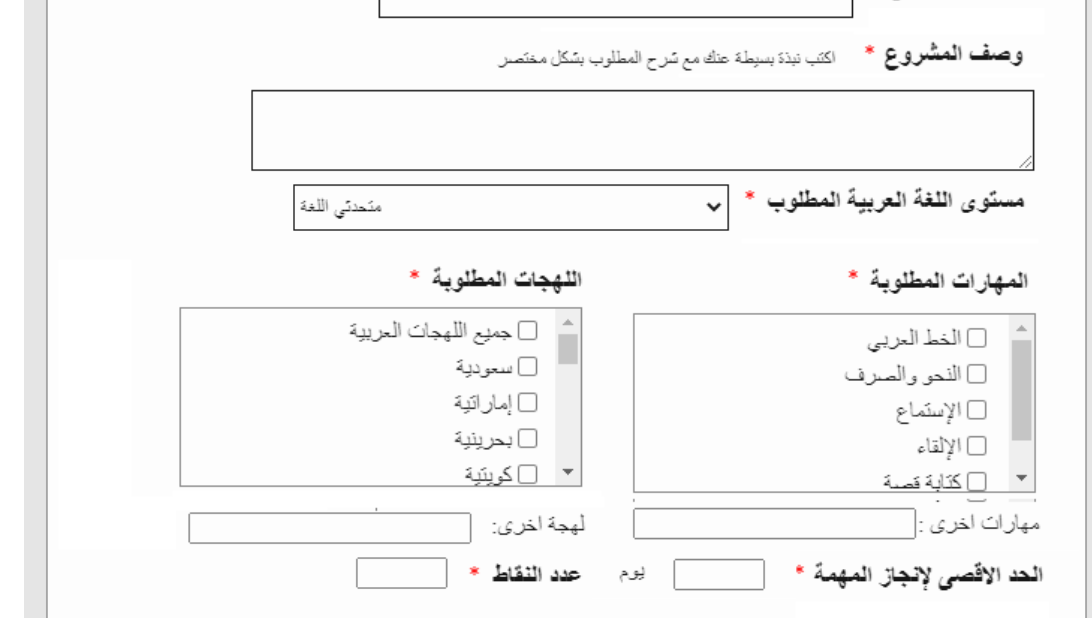
Figure 4. Project setting.